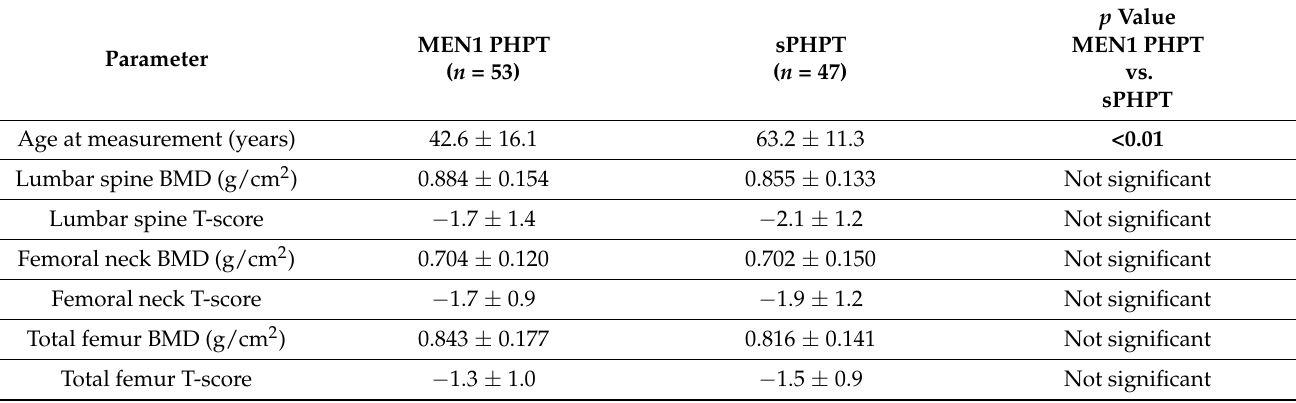
Table 4. Comparison of DXA parameters, measured before PTX or in PHPT patients who did not undergo PTX, between MEN1 PHPT and